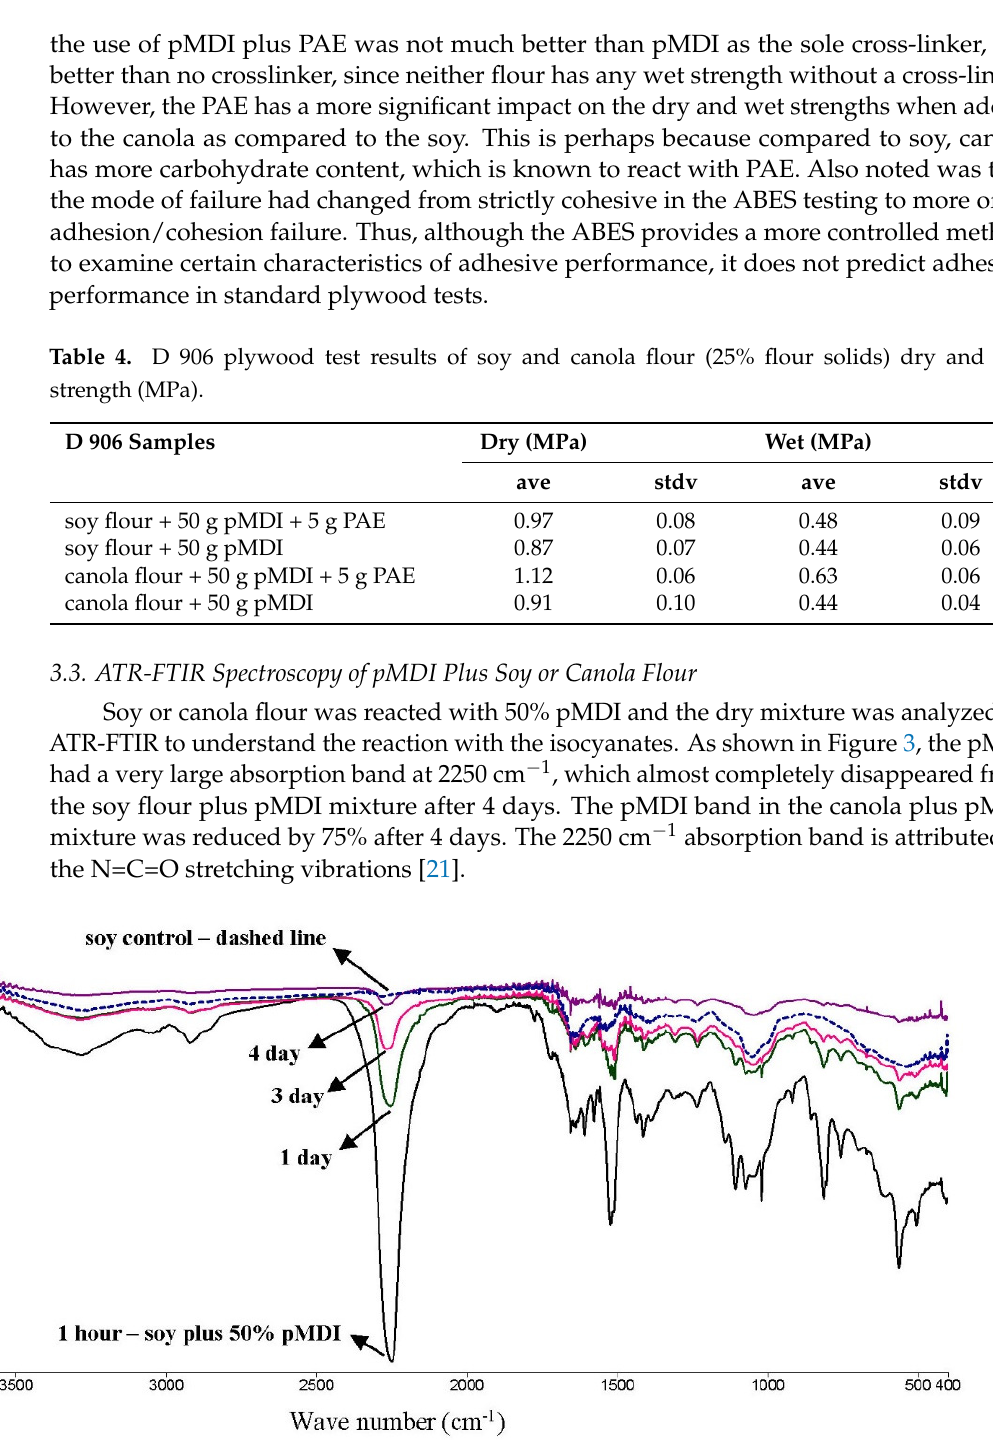
Table 4. D 906 plywood test results of soy and canola flour (25% flour solids) dry and wet strength (MPa).